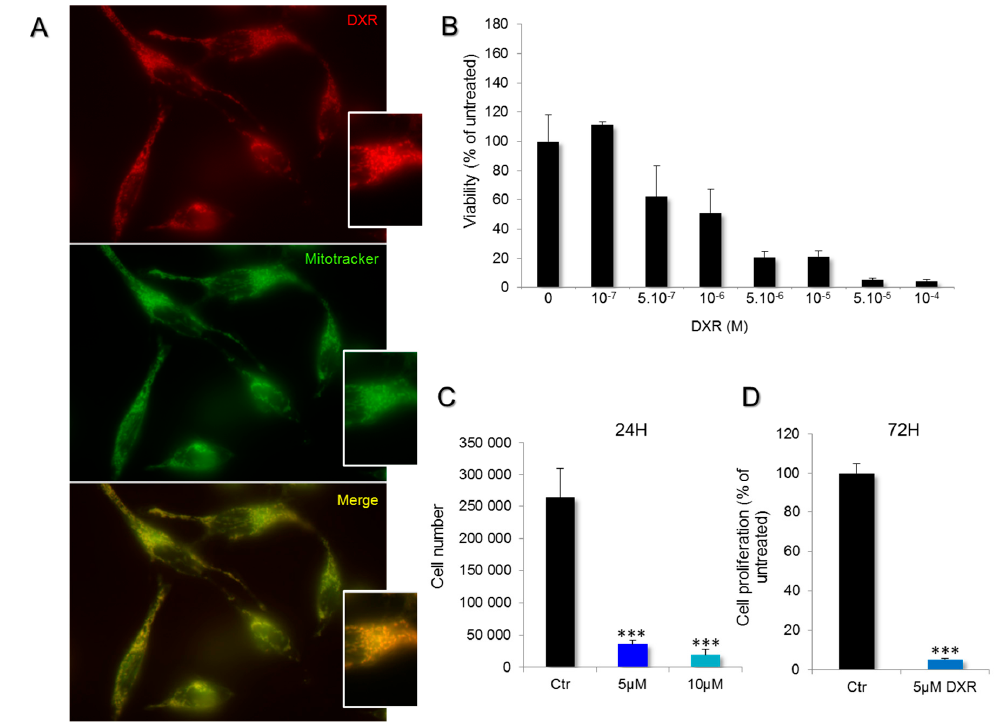
Figure 1. Incorporation of doxorubicin (DXR) in mitochondria of HeLa cells and impact on cell viability. ( A ) Living cells were treated with 100 nM Mitotracker Green and 5 µM DXR, for 30 and 10 min, respectively. The overlaps between mitochondria (green) and DXR (red) are shown in yellow. ( B ) The viability of HeLa cells was estimated after doxorubicin treatment for 24 h with a range of concentrations between 10 –7 and 10 –4 M. ( C ) The proliferation was measured, after 24 h with DXR (5, dark blue and 10 µM, light blue), by counting the cells in the presence of trypan blue, and it was compared to the condition without DXR, the control (Ctr, black). ***, P < 0.001; One-way ANOVA with multiple comparisons. ( D ) The effect of DXR on cell proliferation was also measured after 72 h of treatment and compared to the control untreated cells. ***, P < 0.001; unpaired t test, two-tailed.